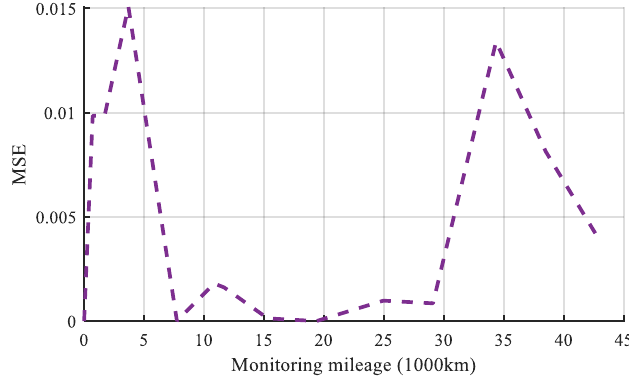
Figure 11. MSE of sample 1.